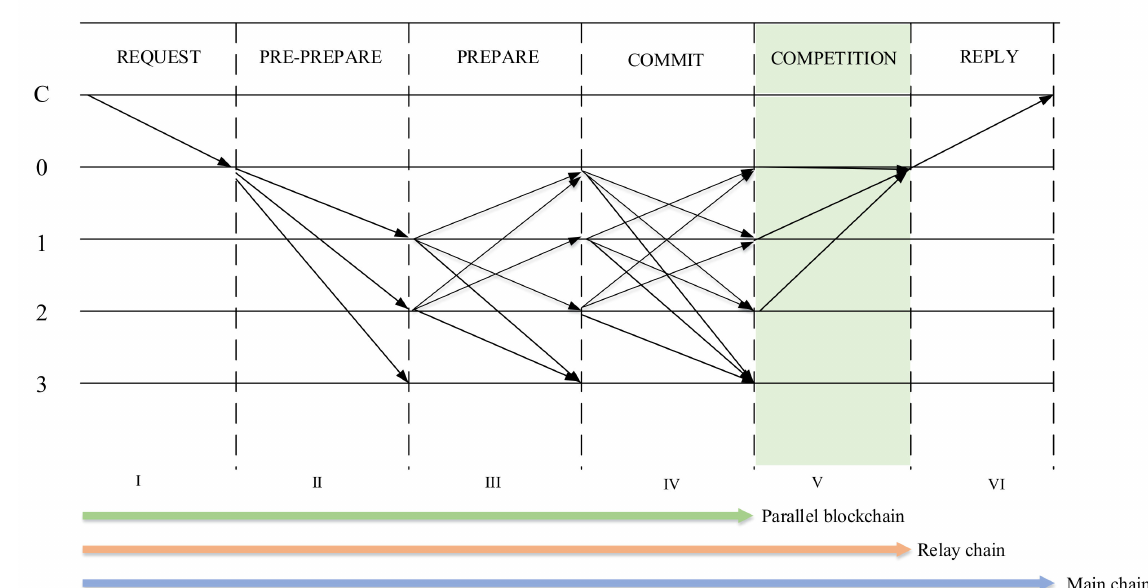
Figure 7. Schematic diagram of SPBFT consensus sequence